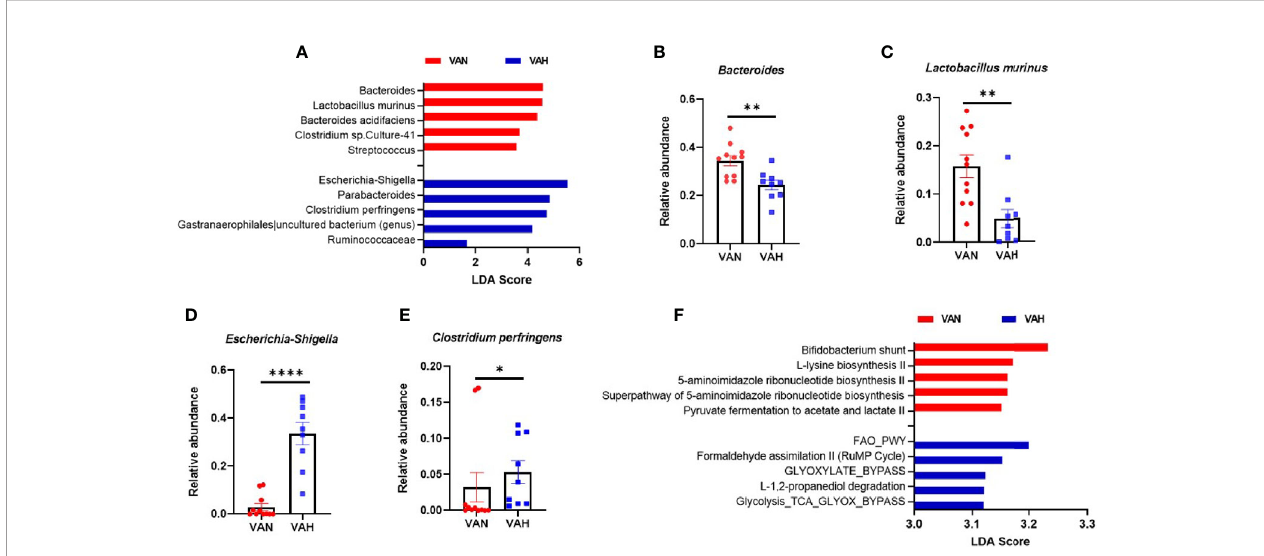
FIGURE 6 | Vitamin A supplementation causes more profound gut dysbiosis with functional consequences in BMT recipients. (A) Lethally irradiated VAN and VAH mice were transplanted with BM (6 – 10 x 10 6 ) plus 0.3 – 0.4 x 10 6 puri fi ed T cells from B6 mice. On Day 7 after BMT, fecal samples were collected and 16S rRNA sequencing was performed. (A) Taxonomic comparison at the genus level using linear discriminant analysis effect size analysis. (B – E) Comparison of relative abundance of taxa at the genus level between the two groups. (B) Bacteroides; (C) Lactobacillus murinus ; (D) Escherichia-Shigella ; (E) Clostridium perfringens ; (n = 9 – 11 per group). Data are shown as Mean ± SEM and are cumulative results from 3 independent experiments. (F) Linear discriminant analysis effect size analysis for the predicted metabolic pathways (KEGG modules) from two groups. Top 5 pathways with an LDA score greater than 3 from each group are shown. Statistics: * P ≤ .05, ** P ≤ .01, **** P ≤